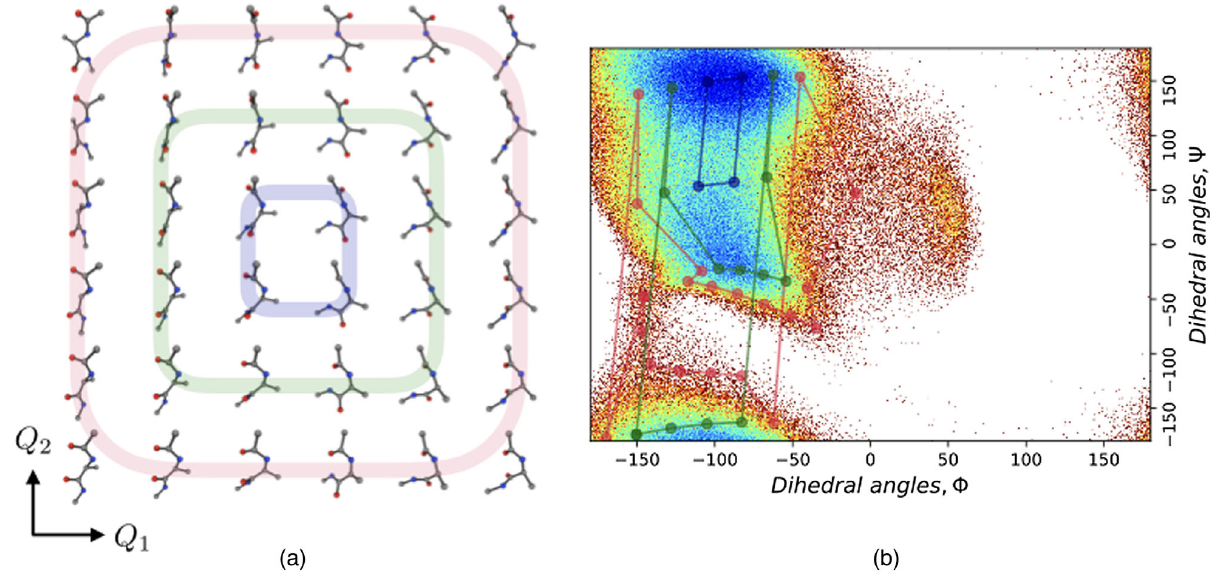
FIG. 5. (a) Latent-space interpolation in the plane of the two slowest collective coordinates ( Q 1 , Q 2 ) generates various molecule conformations. (b) Probability profile of the alanine dipeptide as a function of dihedral angles from generated samples of neural canonical transformation. The paths corresponding to the path with the same color in